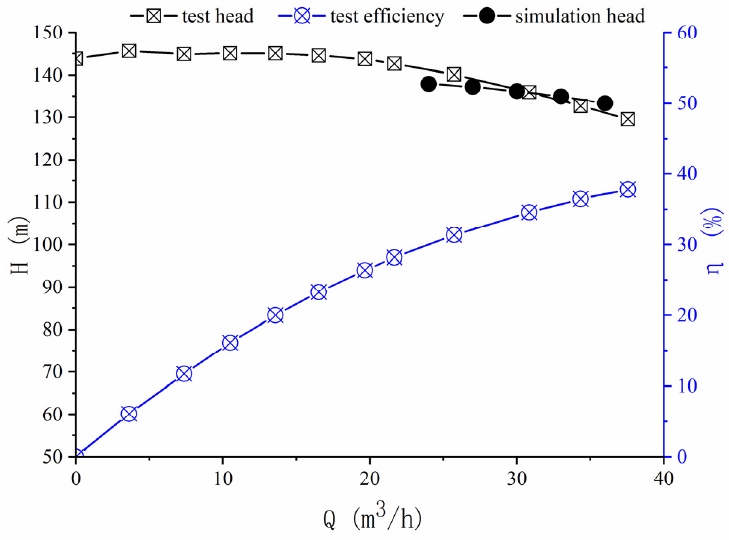
Figure 5. Comparison of simulation and experimental results.